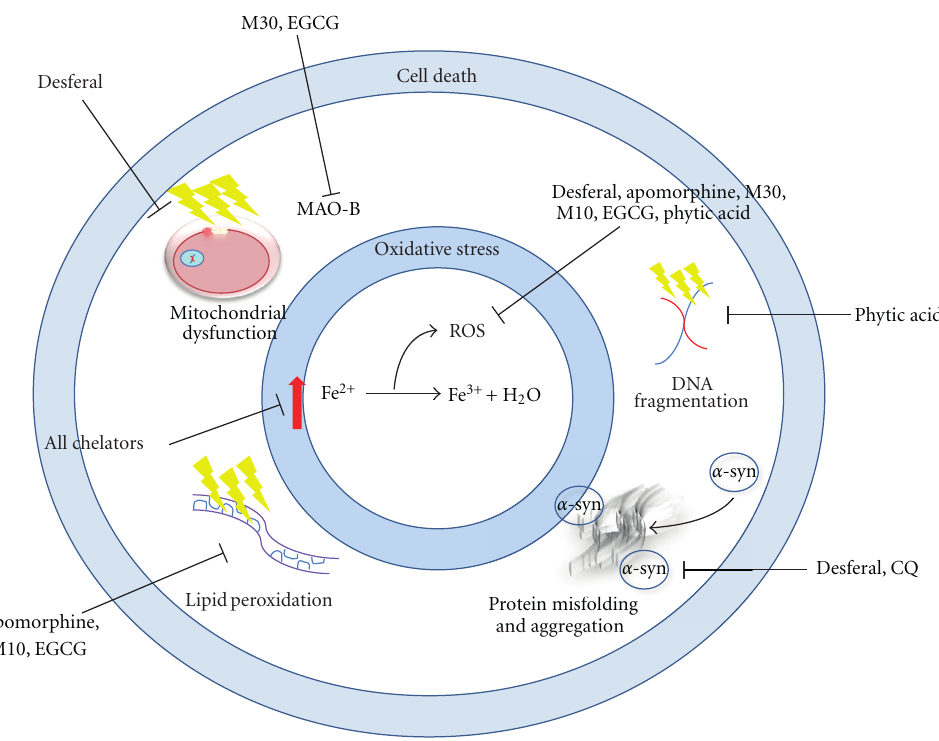
Figure 2: Action of iron chelators targeting PD. All iron chelators mop up excess free, reactive iron, thus reducing the reduction of Fe 2+ to Fe 3+ —a reaction that produces various ROS, such as the hydroxyl radical. Oxidative stress resulting from the generation of ROS produces a range of deleterious insults, which can be targeted with the multiple actions of inhibitors. This can attenuate the cell death that these events induce. Chelators with antioxidant properties inhibit the production of ROS, in an environment of diminished antioxidant activity. The dopamine-oxidising enzyme MAO-B, which resides in the outer membrane of mitochondria, can also be inhibited by some